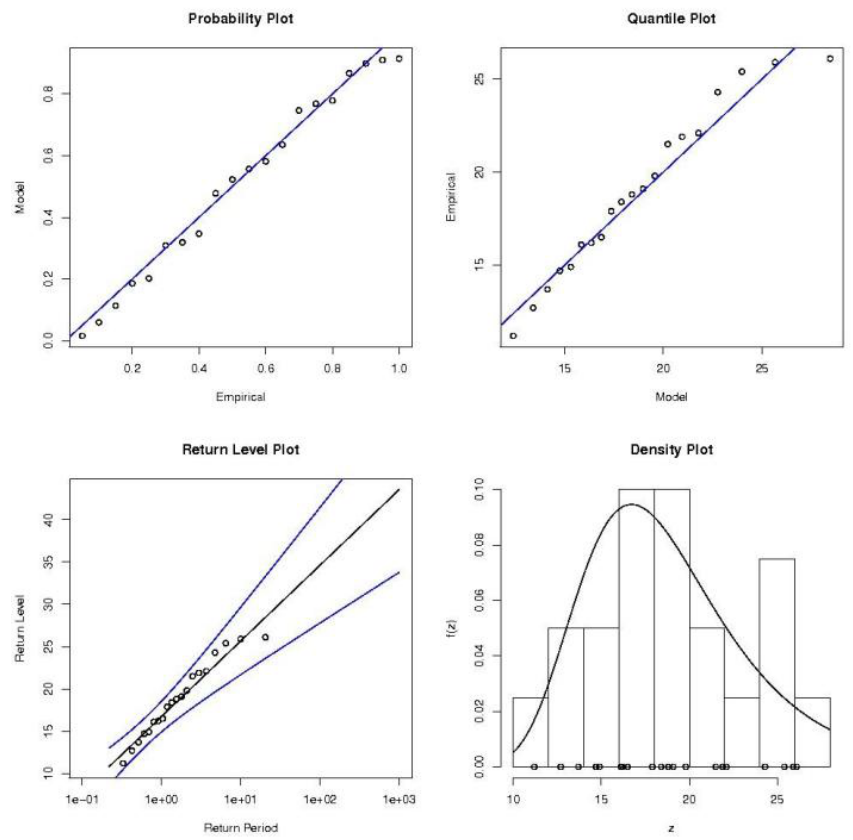
Figure 2. Diagnostic plots for the Gumbel model fitted to the annual maxima of the 15-minutes precipitation data at Karama-Plateau (Coles, 2001).